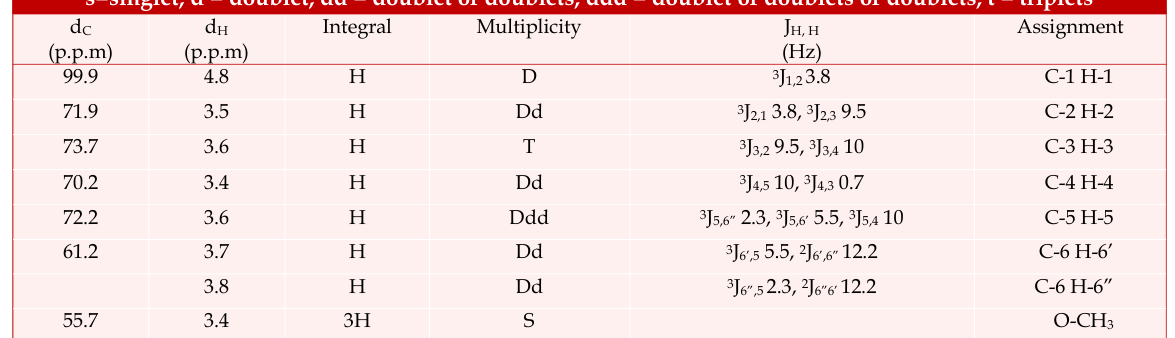
Assignments of the NMR chemical shifts for 13 C (d C ) at 150 MHz and 1 H (d H ) at 600 MHz for Tv-7 sample. s=singlet, d = doublet, dd = doublet of doublets, ddd = doublet of doublets of doublets, t = triplets d C (p.p.m)